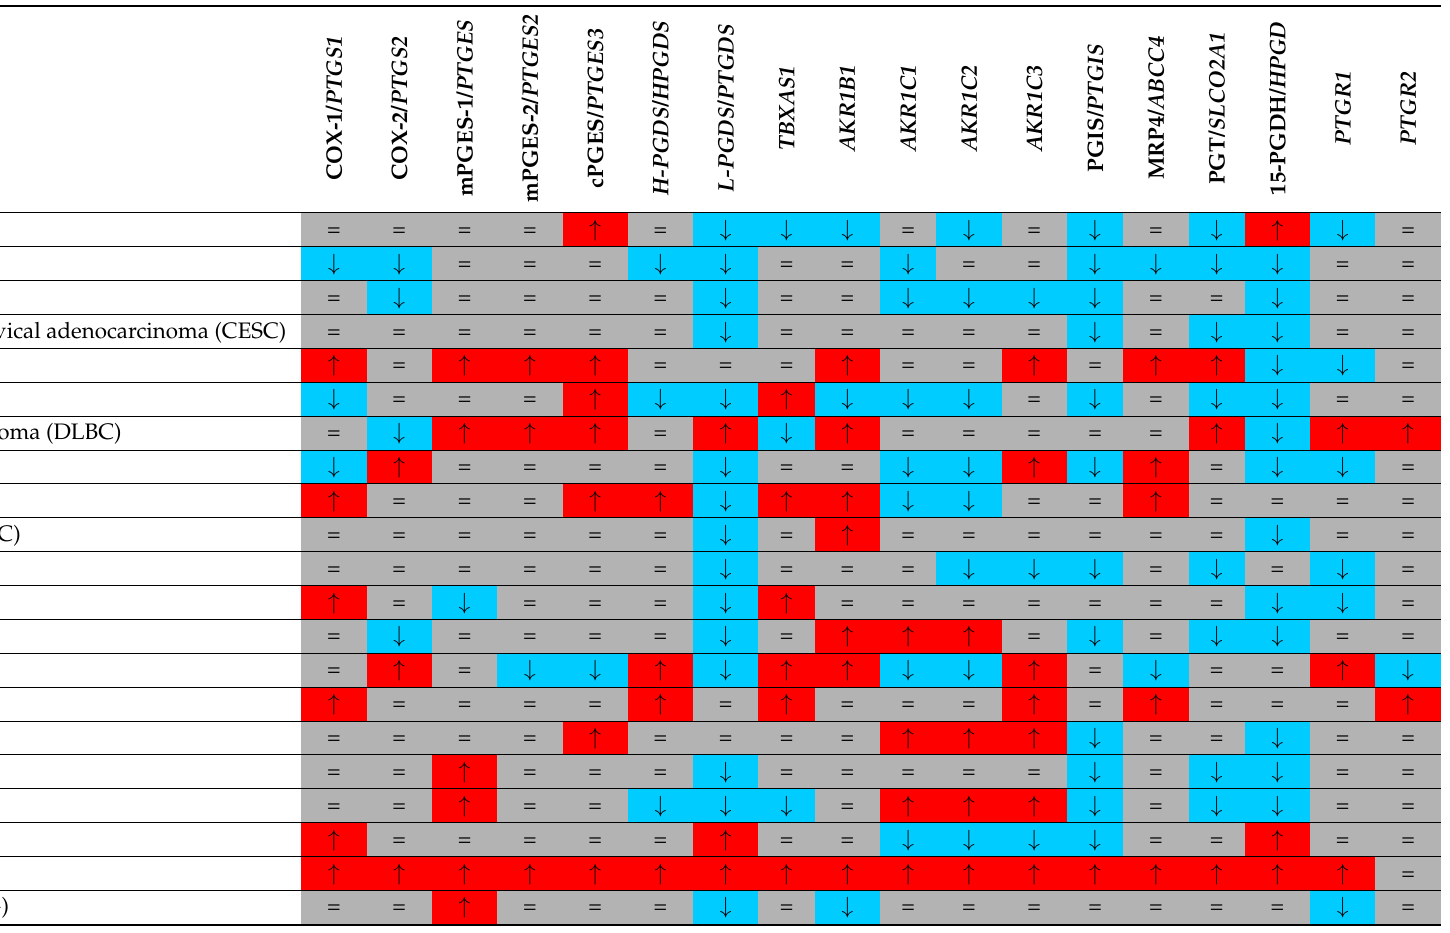
Table 6. Pan-cancer analysis of expression of genes involved in COX